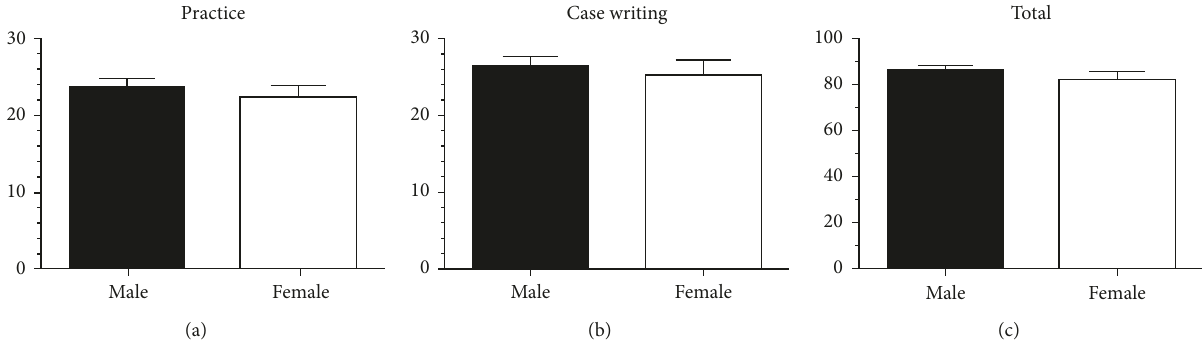
Figure 2: Comparison of scores in LBL at the end of the clerkship. The test scores between genders are represented. (a) Practice scores. (b) Case-writing scores. (c) Total